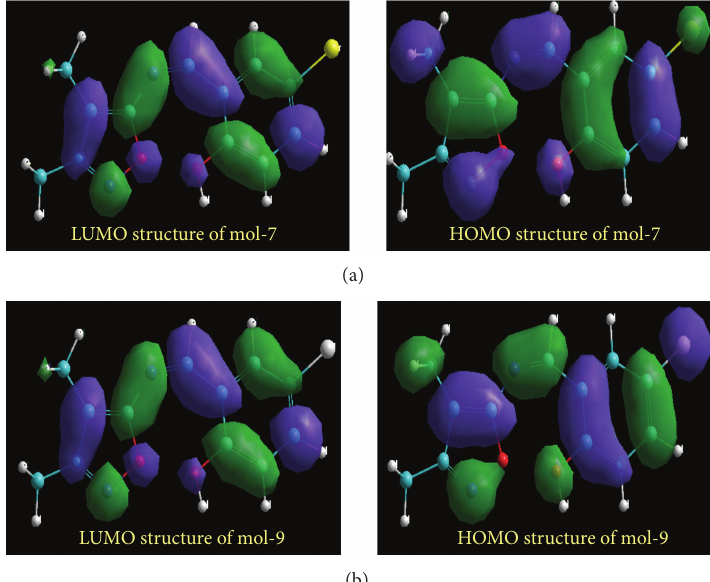
Figure 4: (a) LUMO and HOMO structures for DMIIMBP. (b) LUMO and HOMO structures for DMIIMCP.